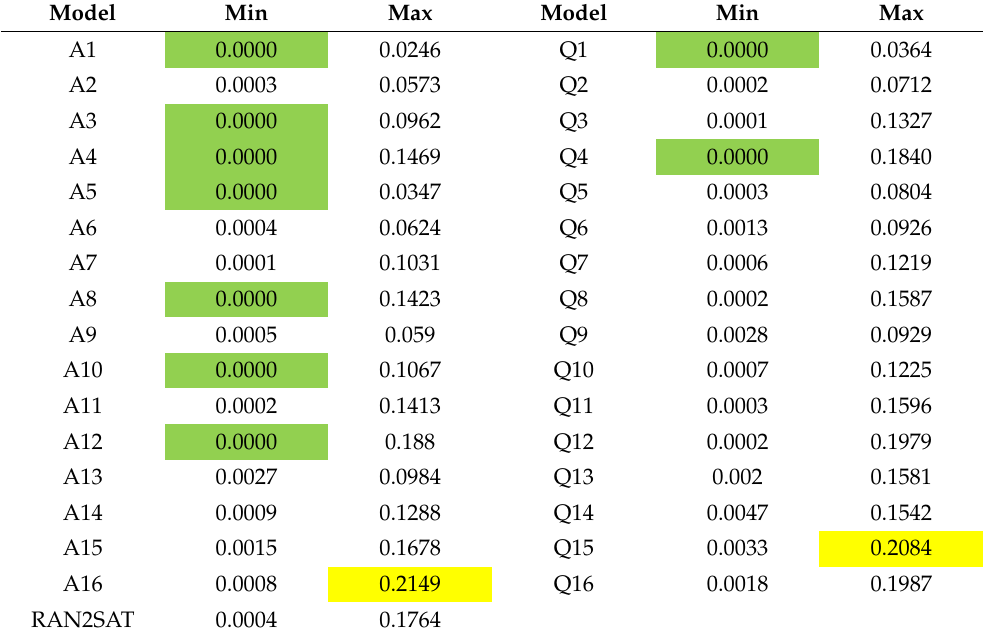
Table 17. Maximum and minimum R tv results for models in both types of logic δ 1 2 SAT ρ , δ 2 2 SAT ρ and